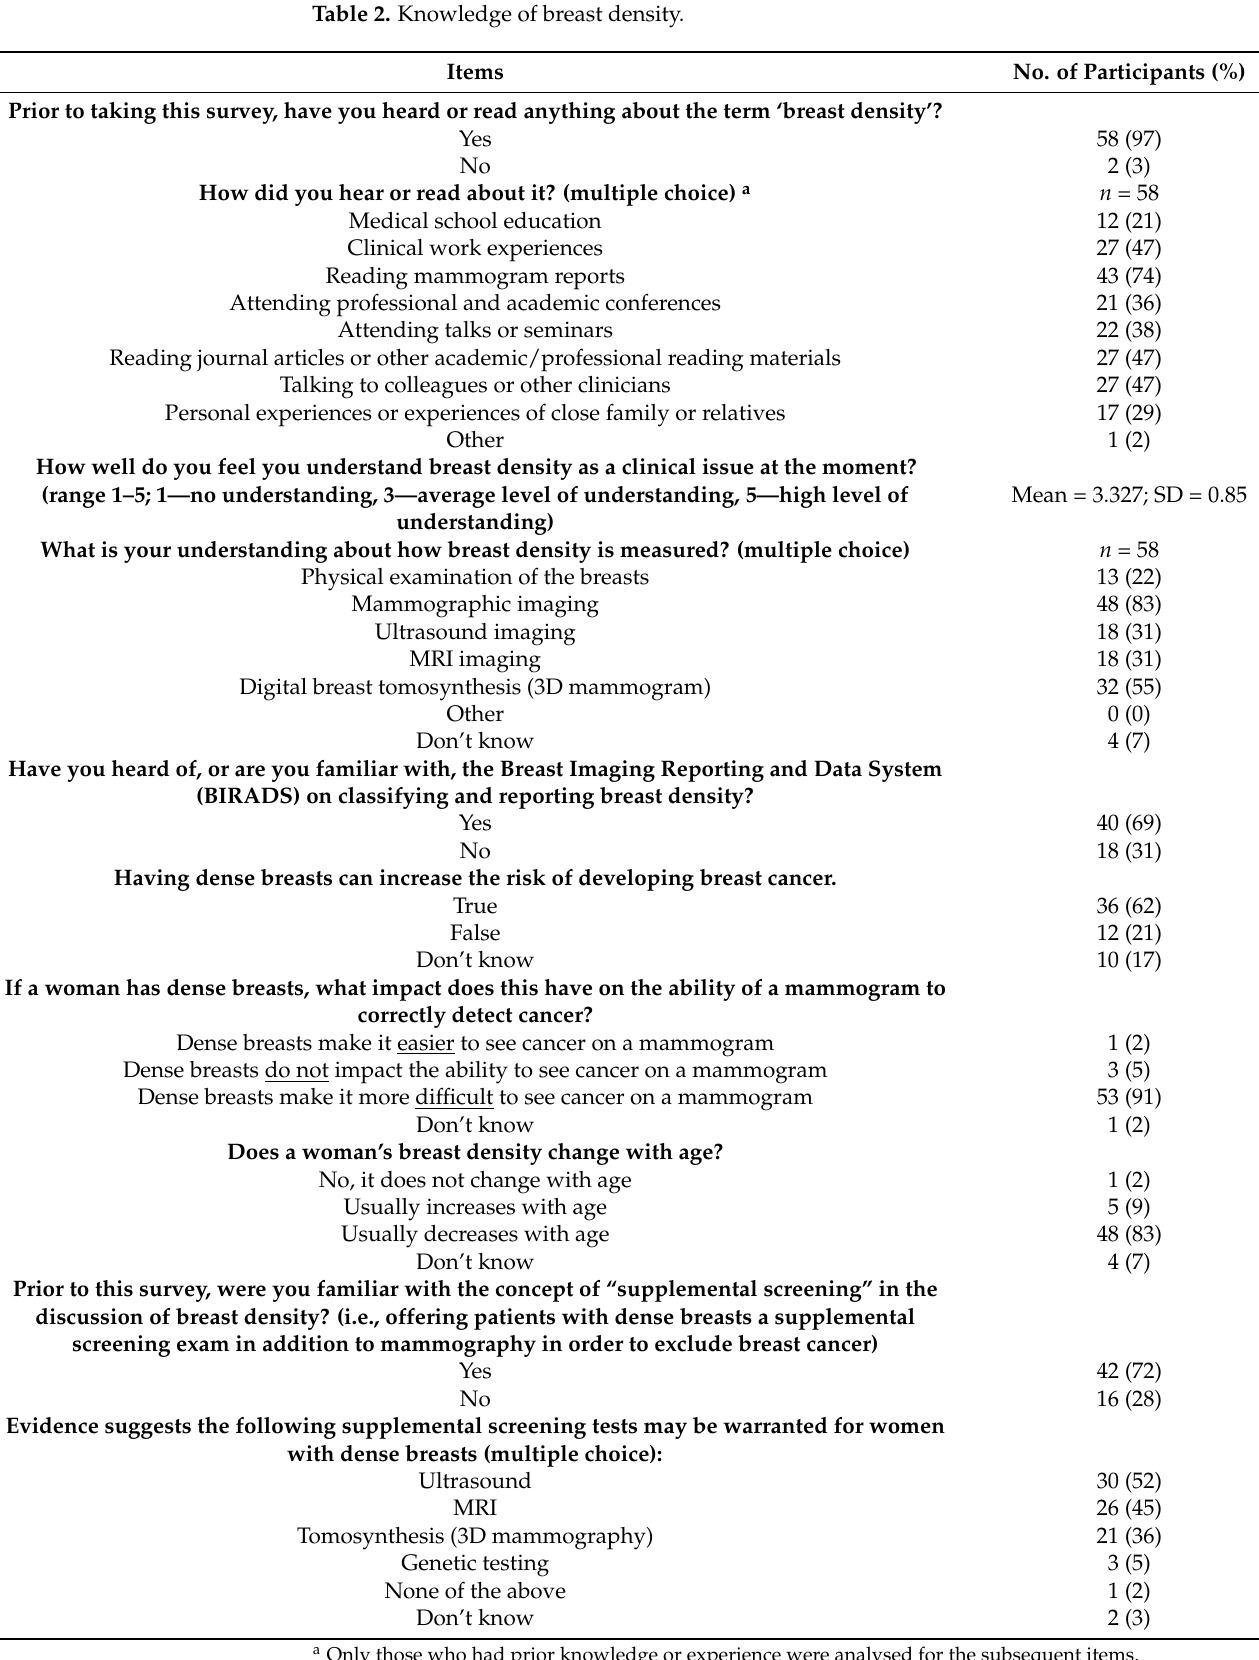
Table 2. Knowledge of breast